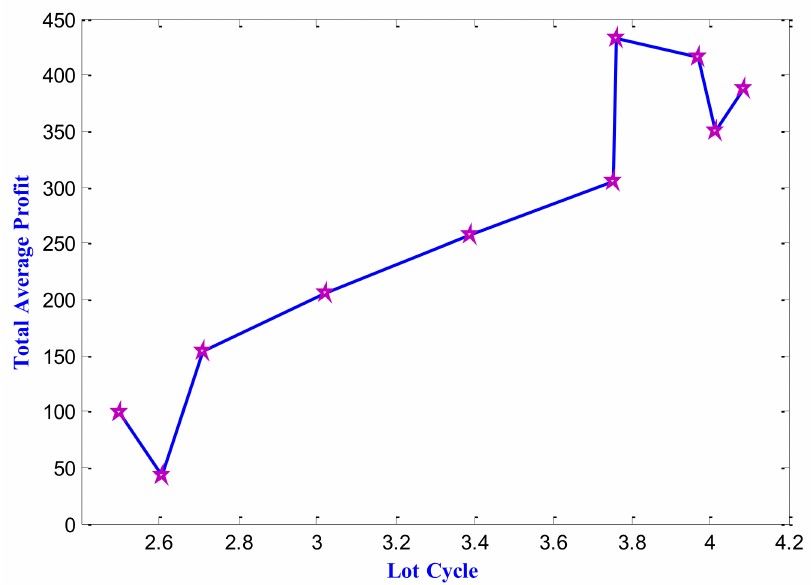
Figure 6. Variation of optimum values of the objective function total average profit ( TAP ∗ ) with respect to the decision variable lot cycle ( Q ∗ ) for the model without shortage.